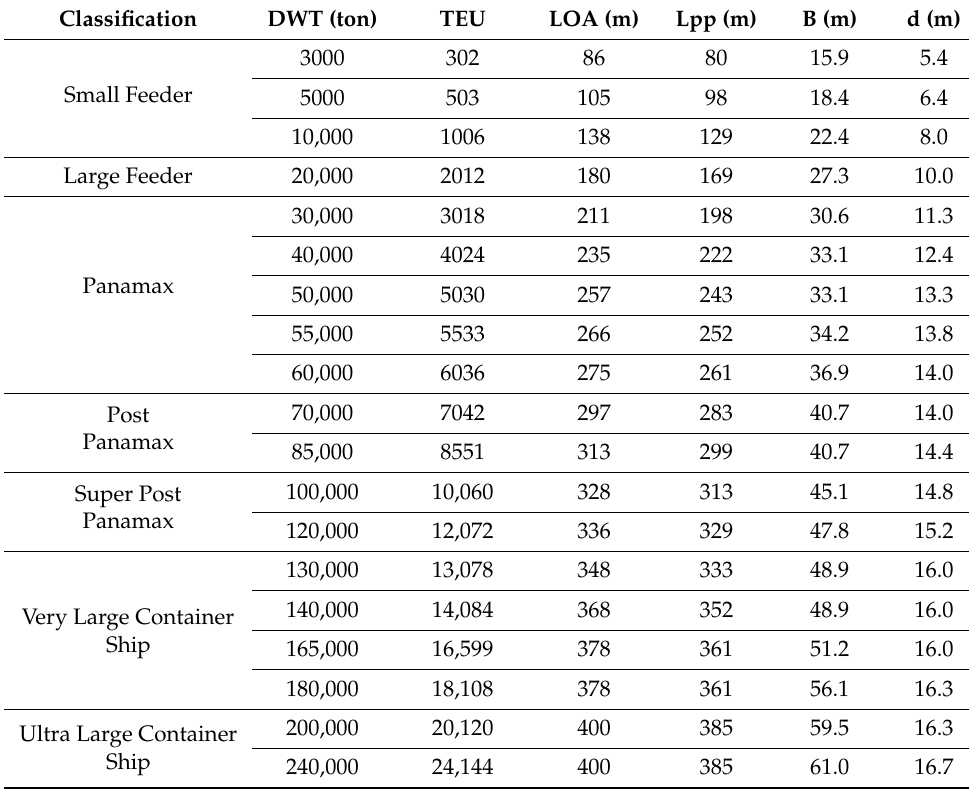
Table 8. Standard design of container ship according to a 75% coverage